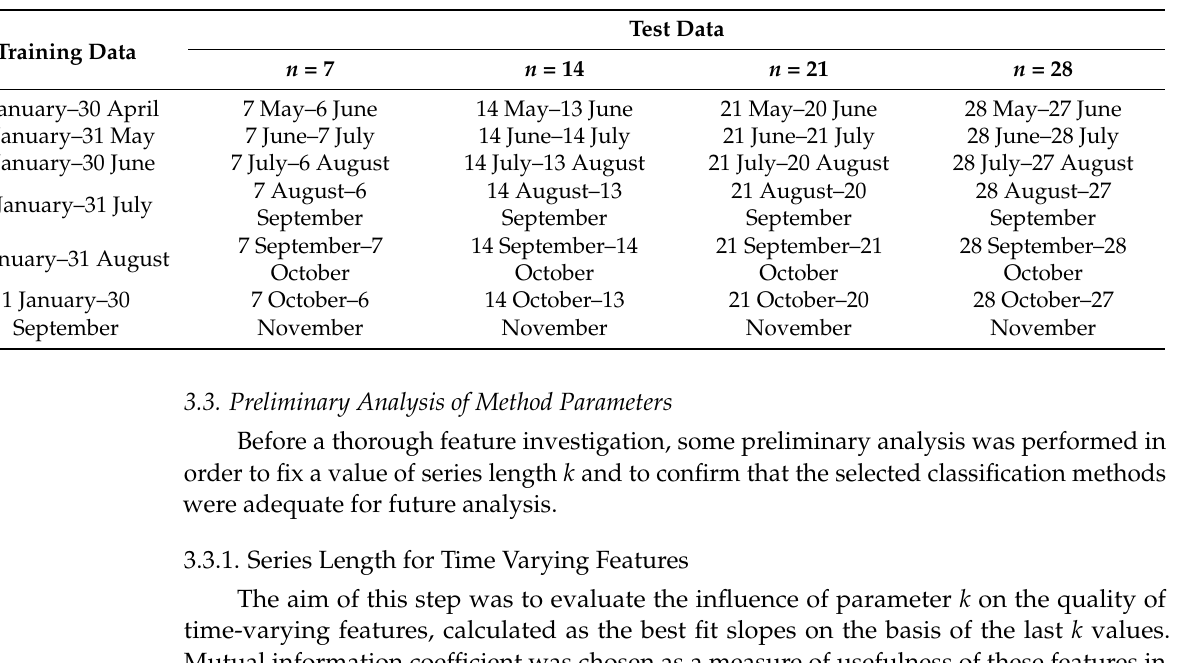
Table 3. Splitting data into training and testing